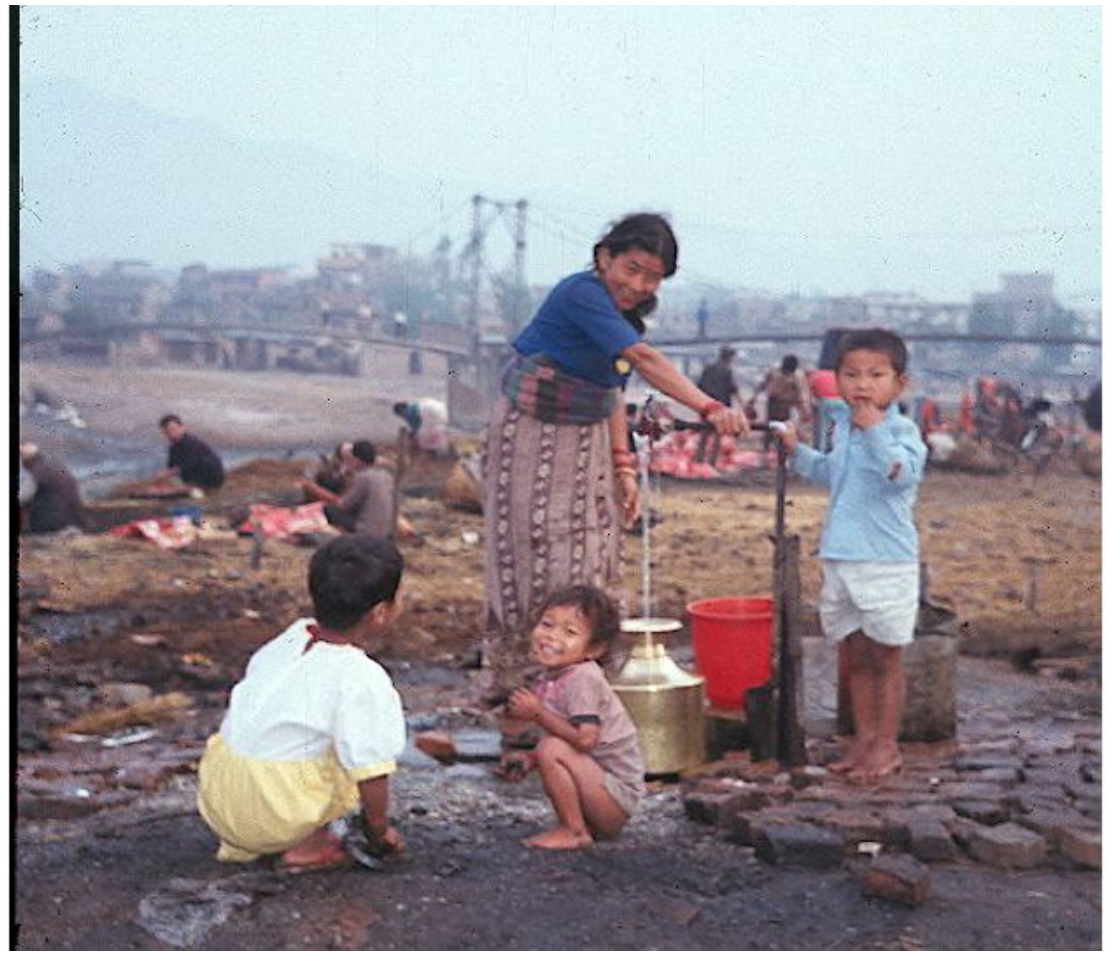
Fig. 1 . The bank of the Bishnumati River adjacent to Wards 19 and 20, Kathmandu,